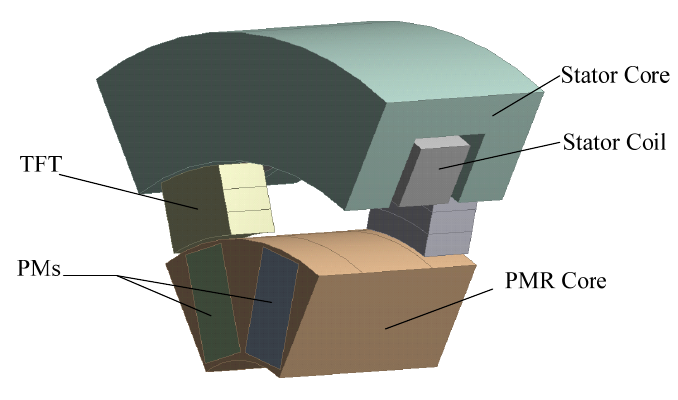
Figure 8. The 3D FEM model.